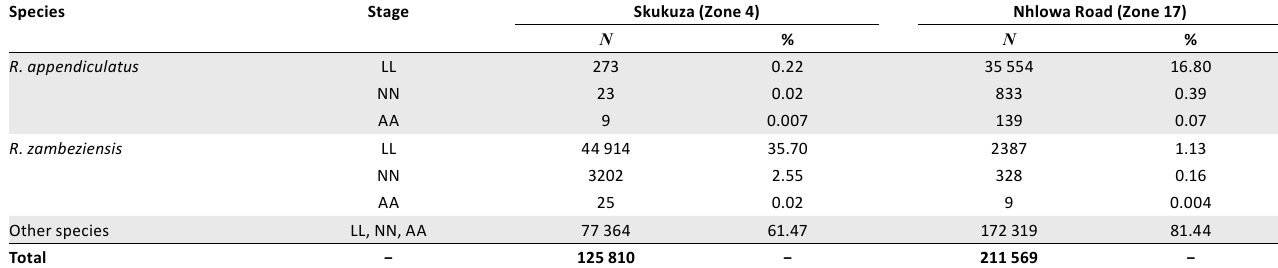
TABLE 1: Number of Rhipicephalus appendiculatus and Rhipicephalus zambeziensis collected in the Kruger National Park by dragging at the Skukuza and Nhlowa Road sites from August 1988 to March 2002.